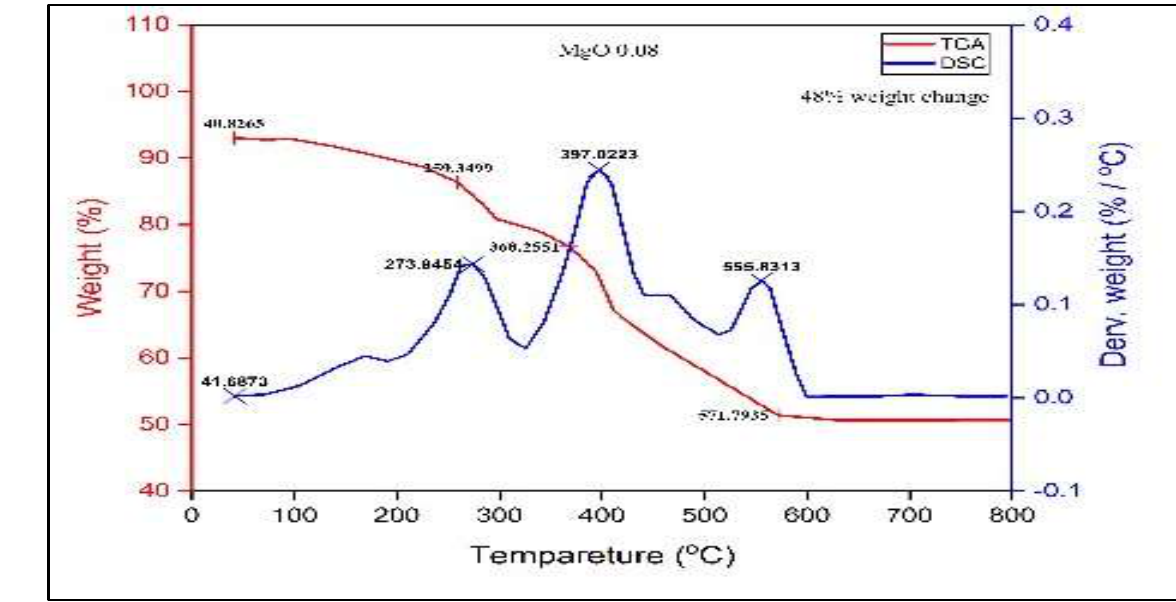
Figure 4 (A, B, C) DSC-TGA curves of the three prepared composites of CHT/ PVA/ PEG/ MgO (0.04, 0.06, 0.08) g, respectively.